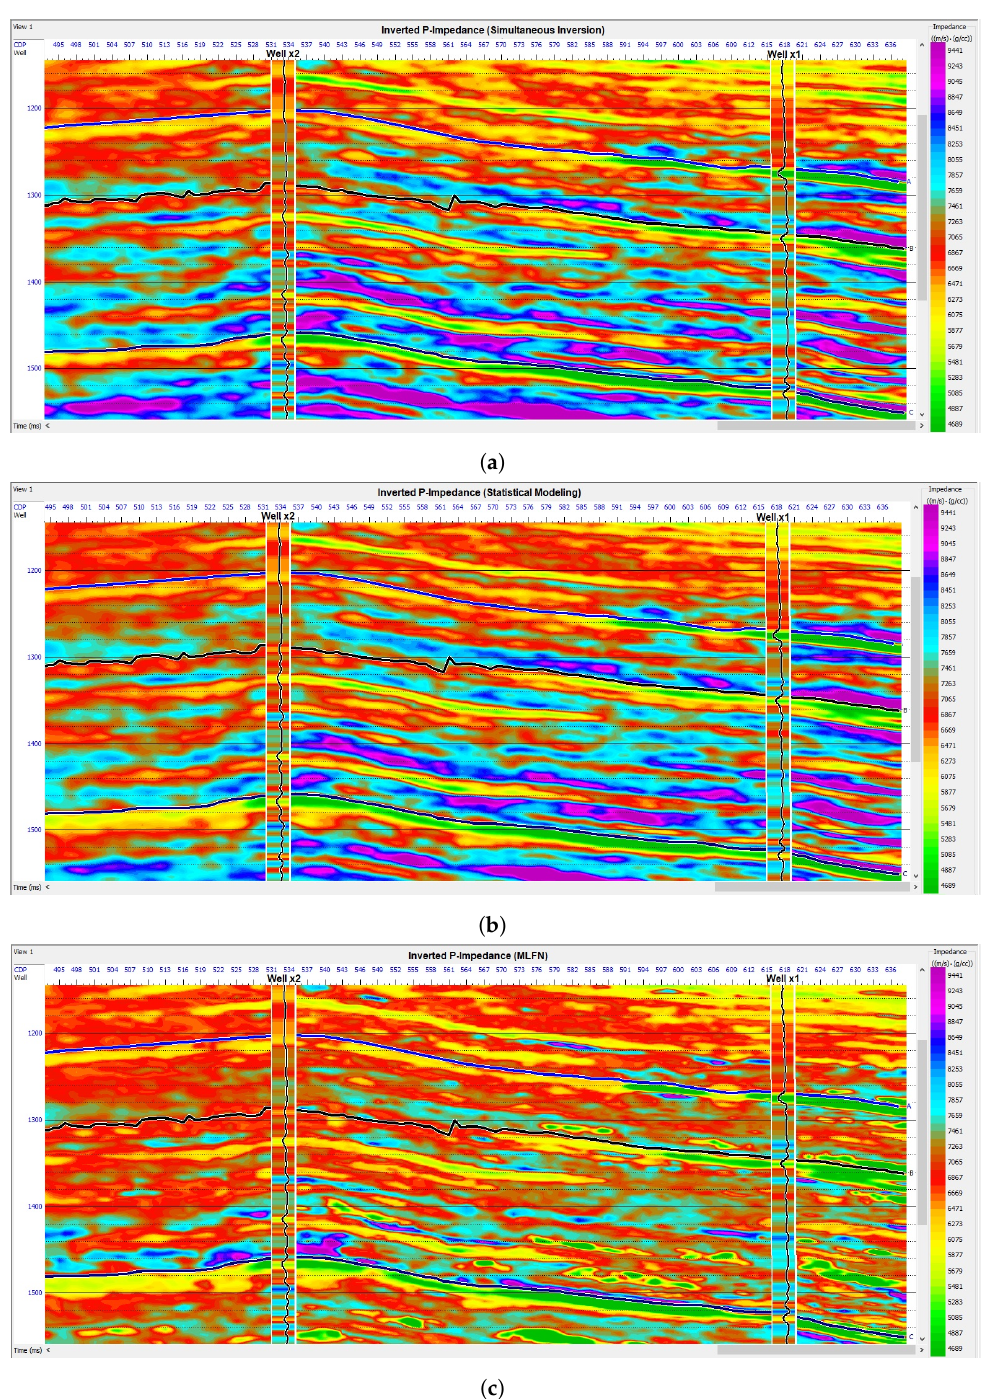
Figure 16. Arbitrary sections extracted from the zero-offset acoustic impedance volumes obtained from ( a ) isotropic inversion, ( b ) statistical modeling, and ( c ) MLFN. The inserted curves are the acoustic impedance logs of the wells × 1 and ×